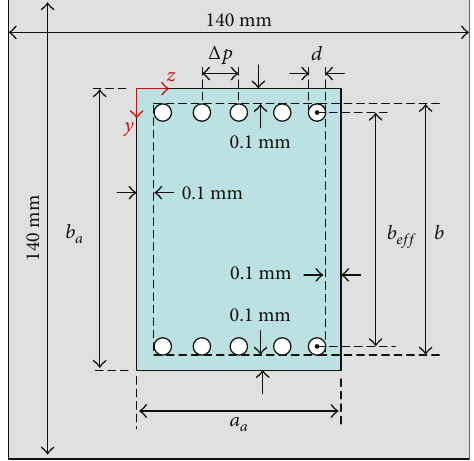
Figure 18: SIW antenna geometry: top